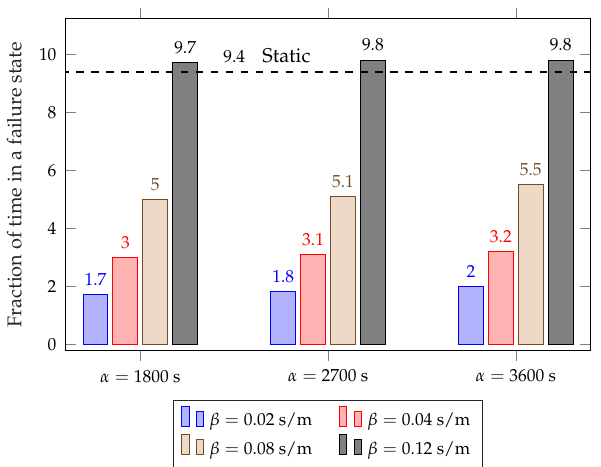
Figure 8. Average fraction of time in a failure state (completely empty or full station) for different values of α and β